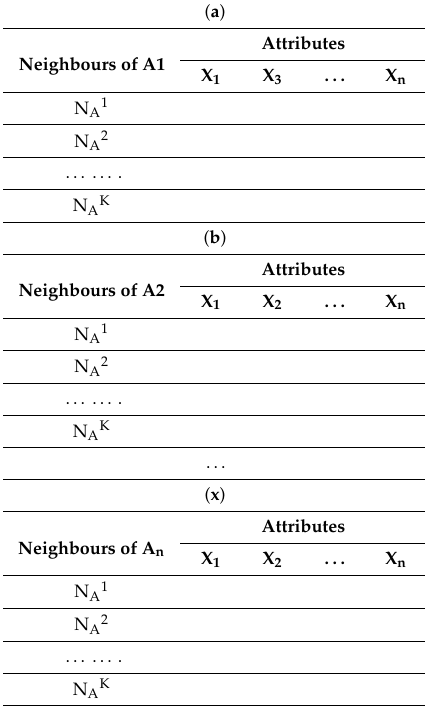
Table 3a–x represent the neighbor sets {NA 1 , NA 2 , . . . , NA K } along with their feature attributes as {X 1 , X 2 , X 3 , . . . , X n } of Node A. The working of IOP is comprised of two phases, i.e., Phase I (Forwarder_Set_Selection) and Phase II (Forwarder_Node_Selection). In Phase I, the authors used Algorithm 1 for the forwarder set selection. In this step, the information collection task was initiated after the nodes were randomly deployed in the area of interest, with specific dimensions. The beginning of the phase started with a broadcast of “Hello Packet” which contained the address and the location of the sending node. If any node received this packet, it sent an acknowledgment to the source and was added to the neighbor list. Table 3. Description of node features for di ff erent neighbor nodes of